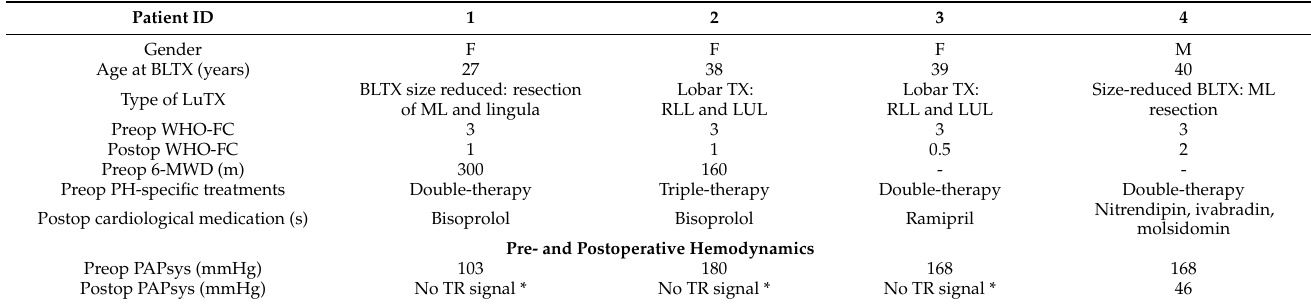
Table 1. Basic demographic and hemodynamic data of iPAH